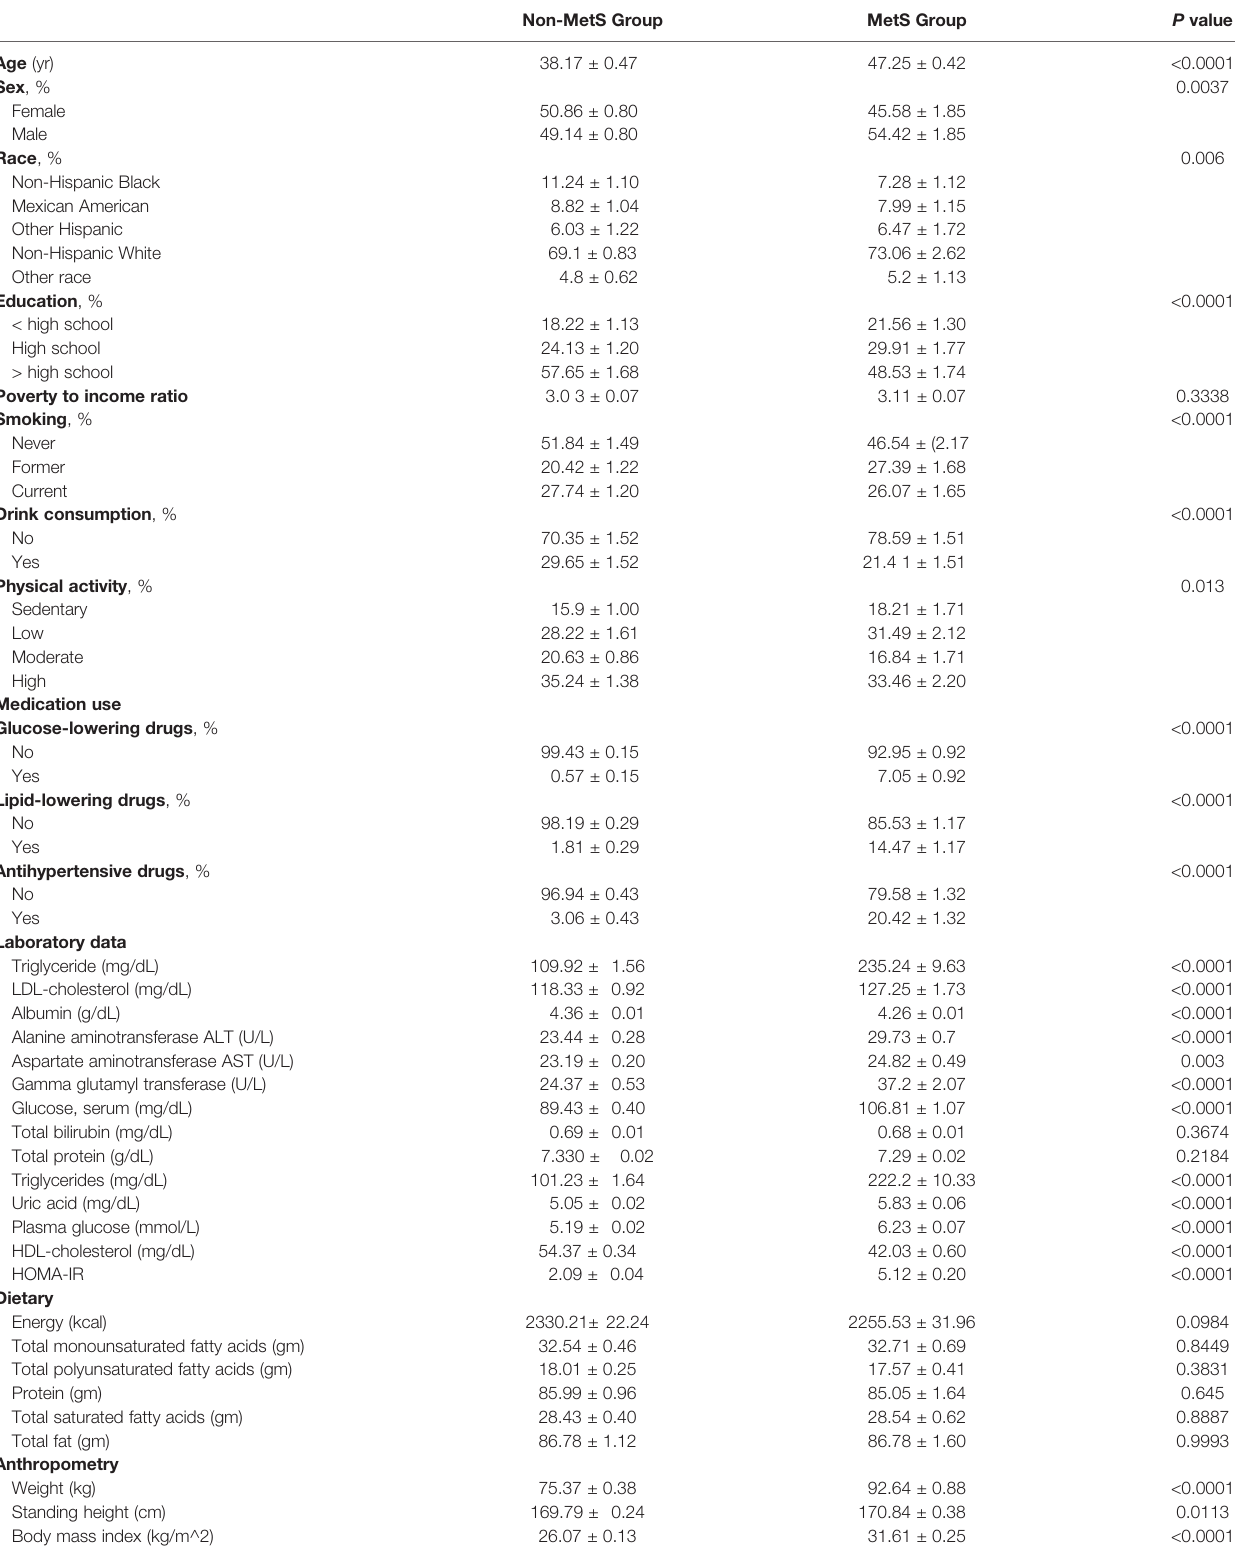
TABLE 1 | Baseline characteristics of the